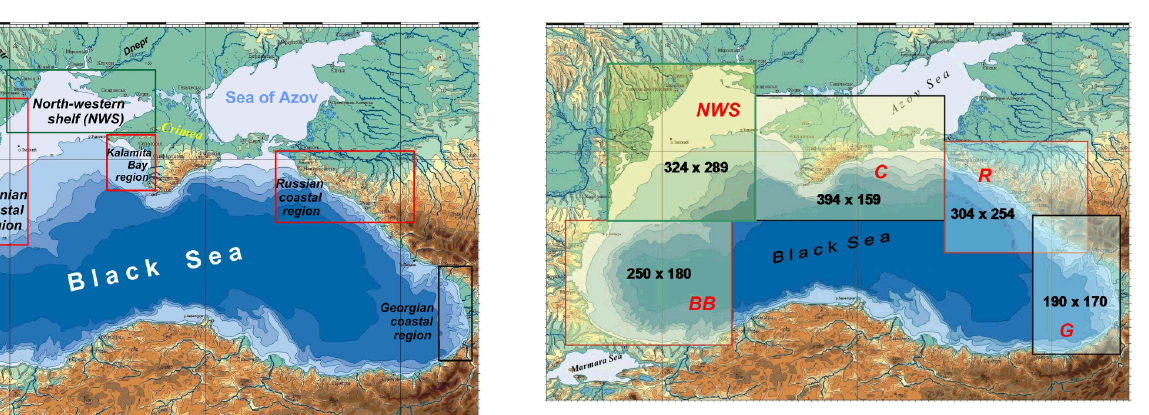
Fig. 1. Nested grid simulation regions of pilot version of the Black Sea coastal forecasting system.